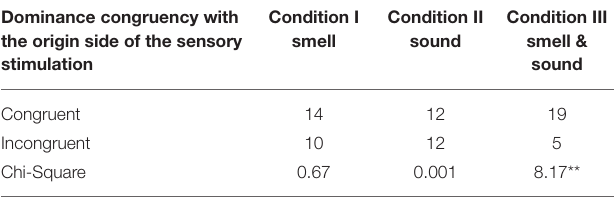
Condition I Condition II Condition III smell sound smell